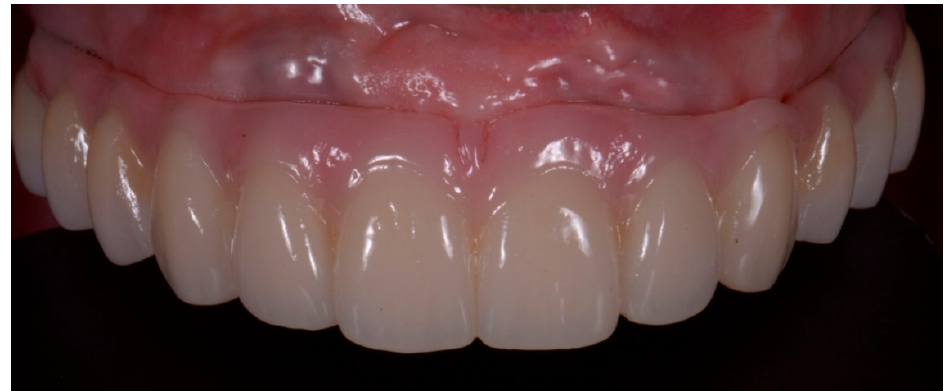
Figure 12. Monolithic zirconia final prosthesis.